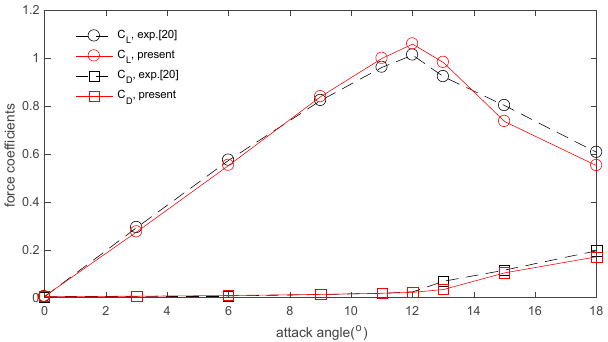
Figure 6. Comparison of force coefficients between the present numerical results and the experimental data in [20] (NACA0018 air foil with chord length of 0.3022 m and span length of 0.462 m).